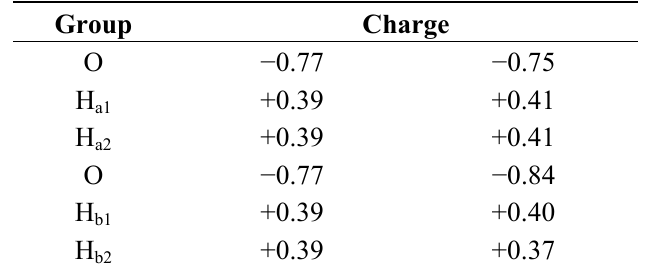
Table 5. Charges of atoms in the fragments and in complex of 3